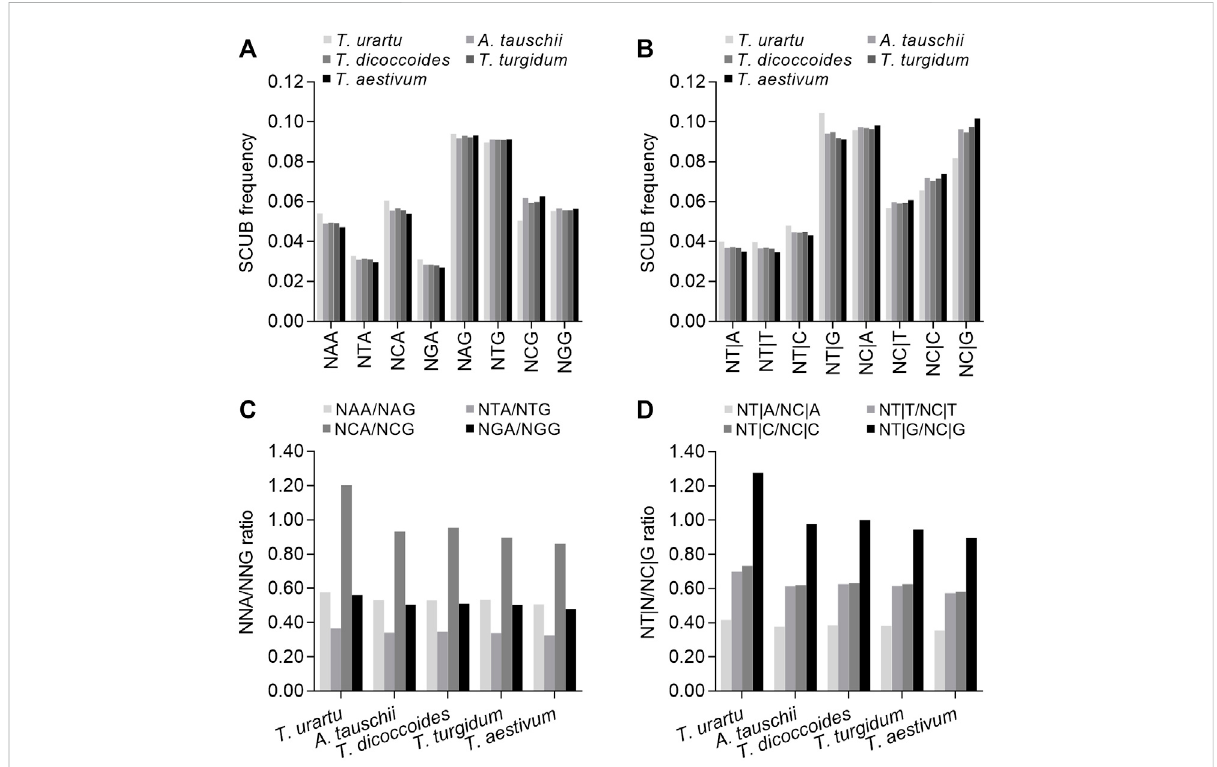
FIGURE 4 AssociationbetweenSCUBandDNAmethylation-drivenconversionofcytosinestothymines. (A) SCUBfrequenciesofNNAandNNGindicating theeffectofthesecondnucleotidepositionofcodonsontheconversionofCtoTatthethirdpositionontheantisensestrand. (B) SCUBfrequencies of NT|N and NC|N indicating the effect of the fi rst nucleotide position of the next codon on the conversion of C to T at the third position of the previouscodononthesensestrand. (C) RatiosbetweenNNAandNNGcodonfrequencies. (D) RatiosbetweenNT|NandNC|Ntriplets.NNAand NNG:SCswithAandGasthe fi nalbasesandanybaseatthesecondposition;Ndenotesanybase.NT|NandNC|N:SCswithCandTasthe fi nalbase of the previous codon and any base at the fi rst position of the next codon. The difference between hexaploid wheat and its progenitors was calculated by Chi square ( χ 2) test, and the results are presented in Supplementary Table